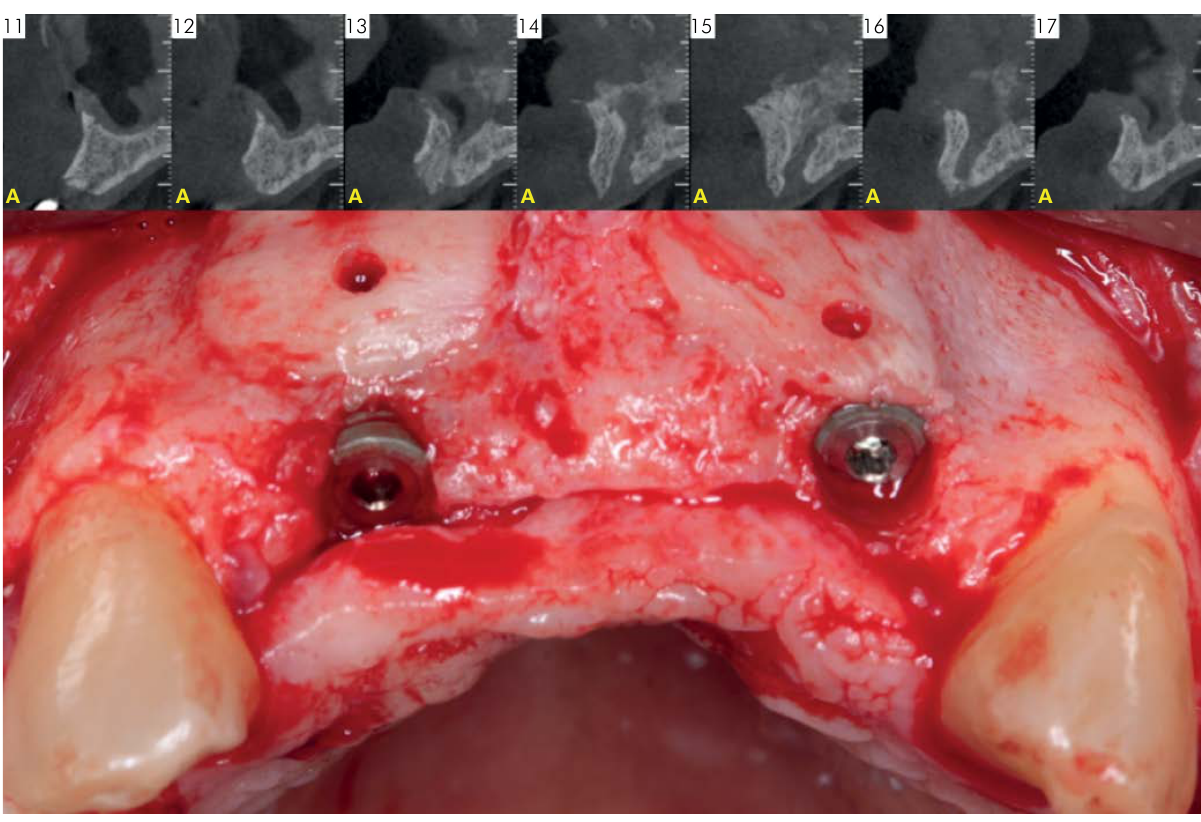
Figure 1. Preoperative tomographic view (parasagittal plane) and clinical view 6 months after horizontal augmentation with osteoconductive material. CT showing the presence of cancellous bone between the buccal and palatal cortical bone plates, despite important bone thickness loss (HAC